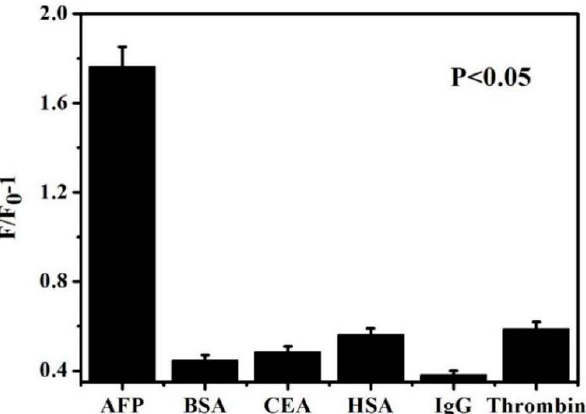
Figure 8. Effects of AFP and interferences BSA, CEA, HSA, IgG, and thrombin on the sensor under optimal conditions.